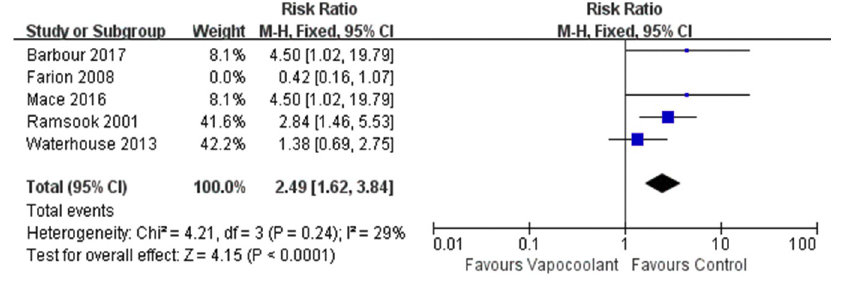
Fig 12. Forest plot of procedural